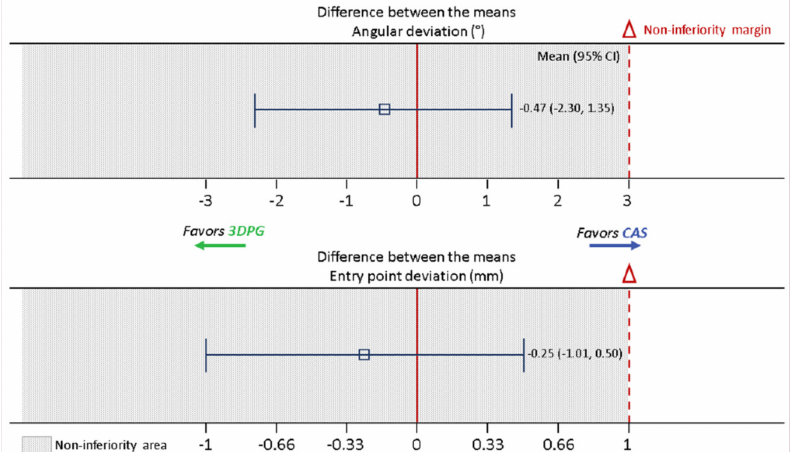
Figure 5. Graph displaying non-inferiority of 3DPG (test) relative to CAS (active control). The error bars demonstrate two-sided CIs, displaying both the lower and upper bounds of the CI. For both outcome measures, 3DPG was non-inferior relative to CAS, given that the entire CI was below the predetermined non-inferiority margins ( ∆ ). It should be noted that a smaller outcome value (less deviation) indicated a better outcome. Therefore, areas to the left indicated better outcomes, and areas to the right indicated worse